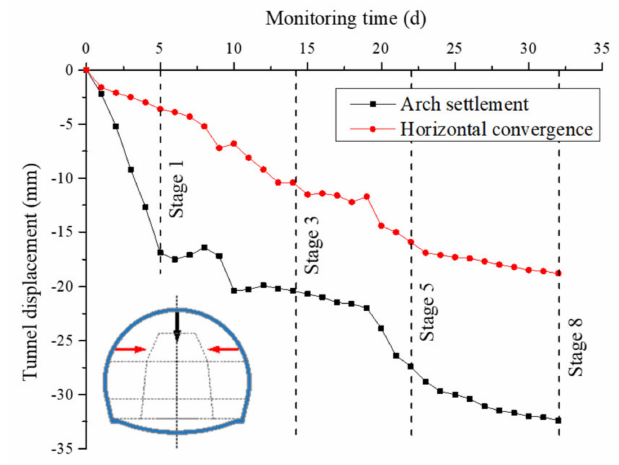
Figure 9. Tunnel displacement–time curves of section DK70 +